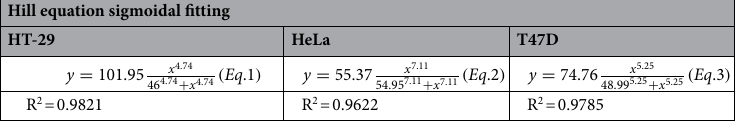
Table 5. Hill equation on correlation between antioxidant activity and cell anticancer activity of extract towards cancer cell lines.